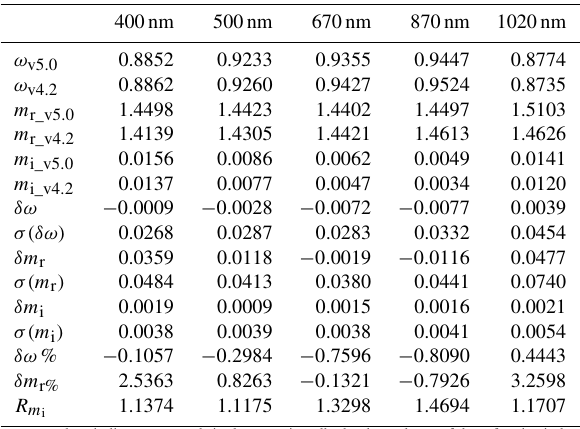
ω , m r , and m i indicate averaged single scattering albedo, the real part of the refractive index, and the imaginary part of the refractive index; subscripts v5.0 and v4.2 indicate parameters retrieved by SKYRAD V5.0 and V4.2, respectively; δ - and δ -% indicate absolute and percentage difference between SKYRAD V5.0 and V4.2, respectively; σ ( δ) indicates the standard deviation of absolute differences between SKYRAD V5.0 and V4.2; R m i indicates the ratio of m i_v5 . 0 to m i_v4 . 2 . Table 4. The same as Table 3 but for Yucheng during February 2013 to December 2015.